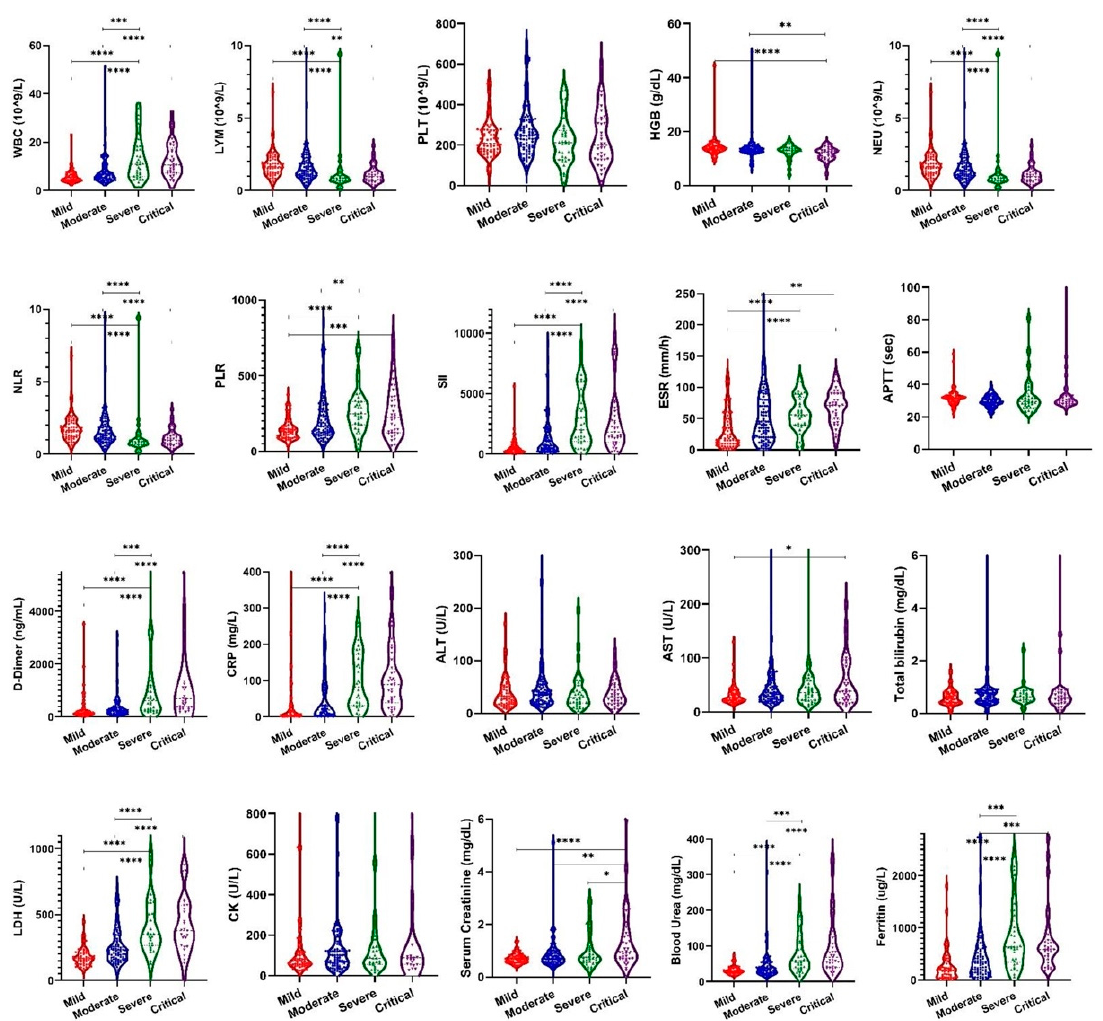
Figure 3. Violin plots showing distribution of laboratory parameter levels on admission. Boxplots indicate median and interquartile range. WHO severity indicates the highest disease severity of the patients during hospitalization. Mild n = 85 samples; moderate n = 98 samples; severe n = 34 samples; critical n = 37 samples. The asterisks indicate that the difference between two groups is significant (* p < 0.05; ** p < 0.01; *** p < 0.001; **** p < 0.0001). However, at admission, there was no statistically significant difference in sex distri-